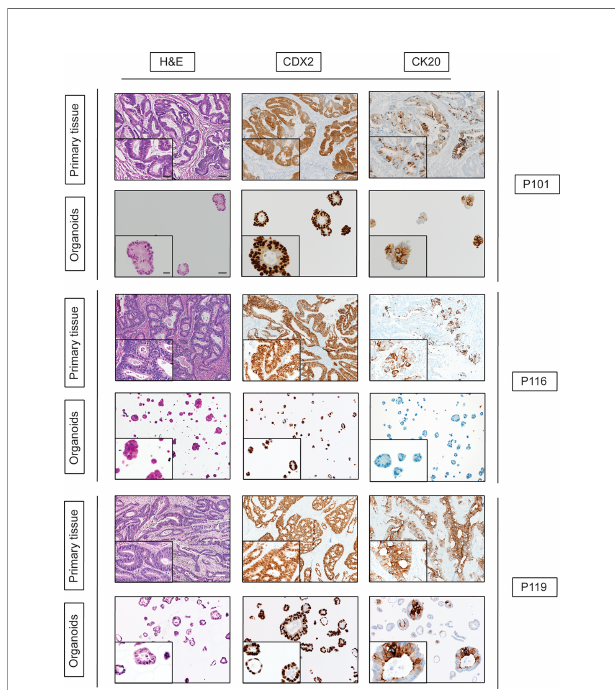
FIGURE 6 | Histologic and immunophenotypic characterization of CRC organoids. Representative micrographs of matched tissue – organoids pairs. Both tissues and organoids sections were stained with hematoxylin – eosin (H&E, left side), CDX2, and CK20 antibodies. For primary tissue pictures, scale bars indicate a size of 100 µm for the picture with lower magni fi cation and 25 µm for the one with higher magni fi cation. For PDOs picture, scale bars are 50 µm and 10 µm for lower and higher magni fi cation,